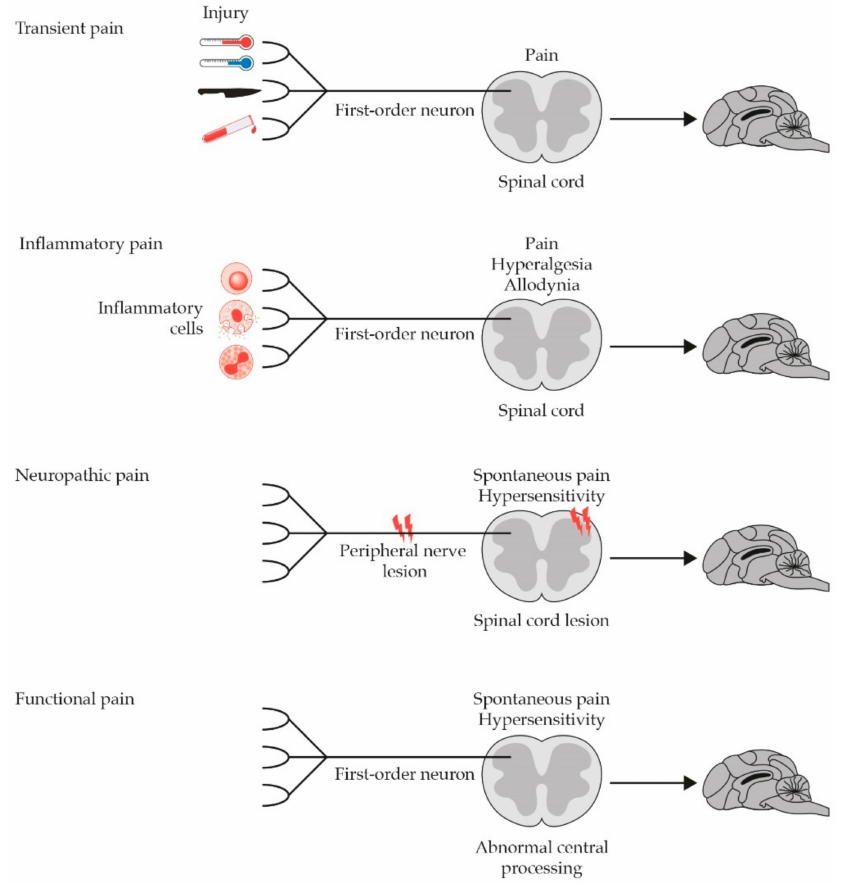
Figure 1. Schematic representation of the four different types of pain, based on their etiopathogenesis. Modified from